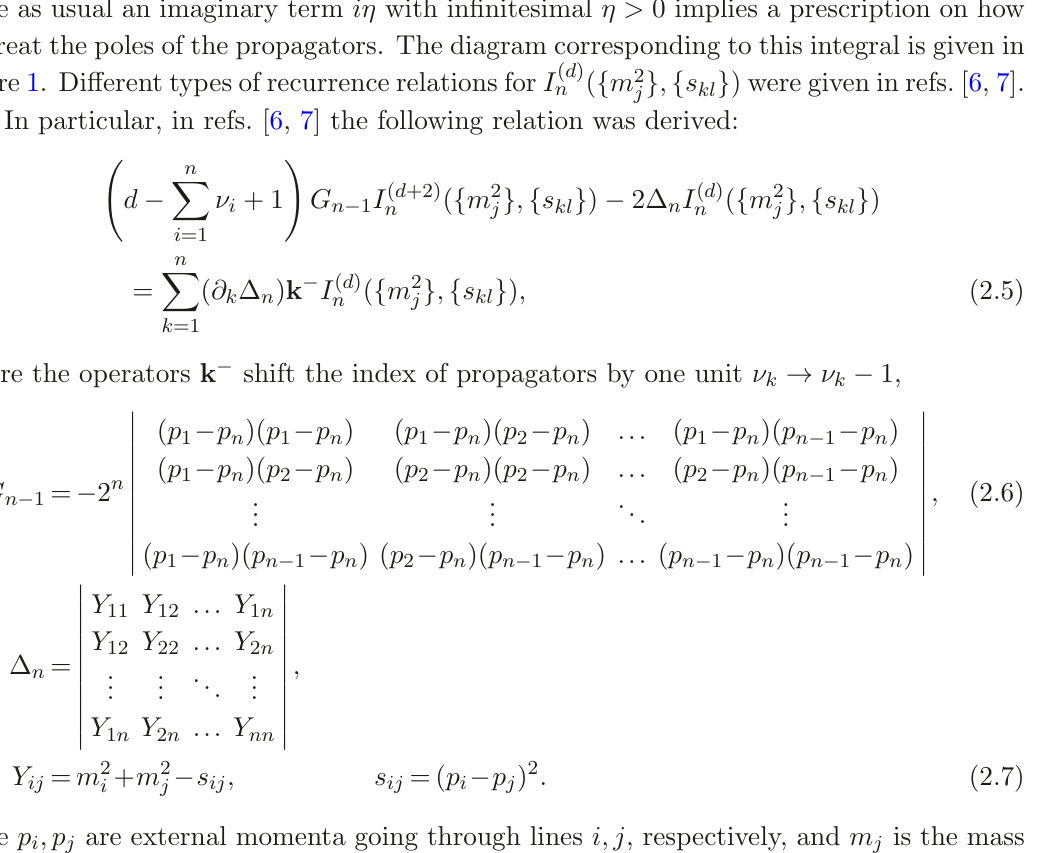
figure 1. Different types of recurrence relations for I ( d ) n (